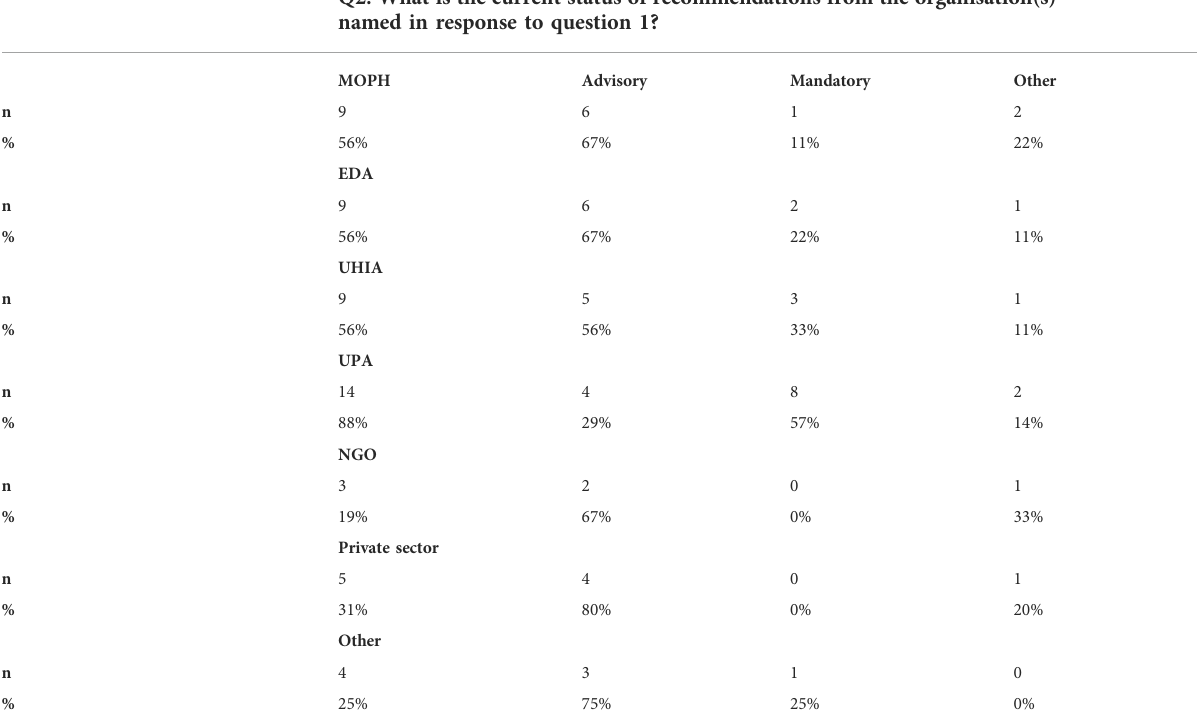
TABLE 1 Stakeholders ’ perceptions about the organizations with a central role in HTA in